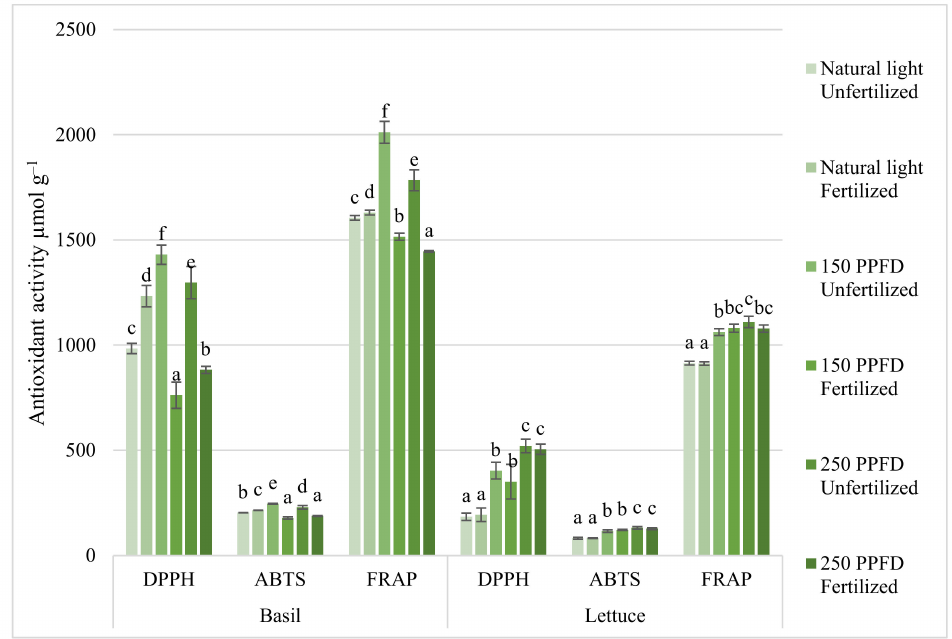
Figure 3. Effect of light intensity and fertilization on basil and lettuce antioxidant system activity. Natural light corresponds to 4.6 mol m − 2 d − 1 ; 150 µ mol m − 2 s − 1 corresponds to 8.6 mol m − 2 d − 1 ; 250 µ mol m − 2 s − 1 corresponds to 14.4 mol m − 2 d − 1 . Values are mean ± SE of 10 replicates, and values with different letters differed significantly according to Tukey multiple comparison test ( p ≤